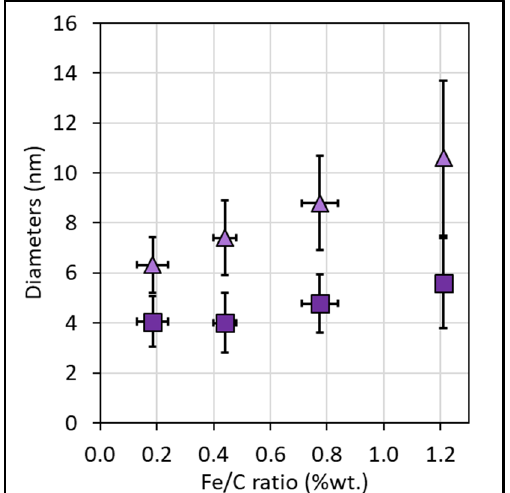
Figure 10. Average CNT external (triangle) and internal (square) diameter obtained on HG-Al substrates. Measurements are performed by TEM on at least 100 CNT observed, the mean values are calculated and reported together with the standard deviation (±2 σ ).